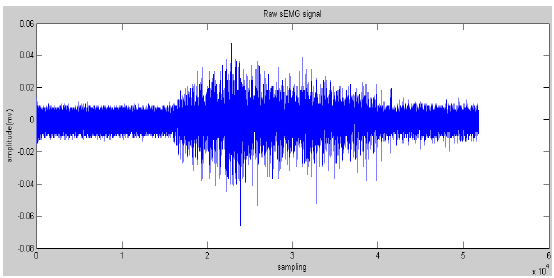
Figure 3. Example of raw sEMG signals recorded from bicep muscles.